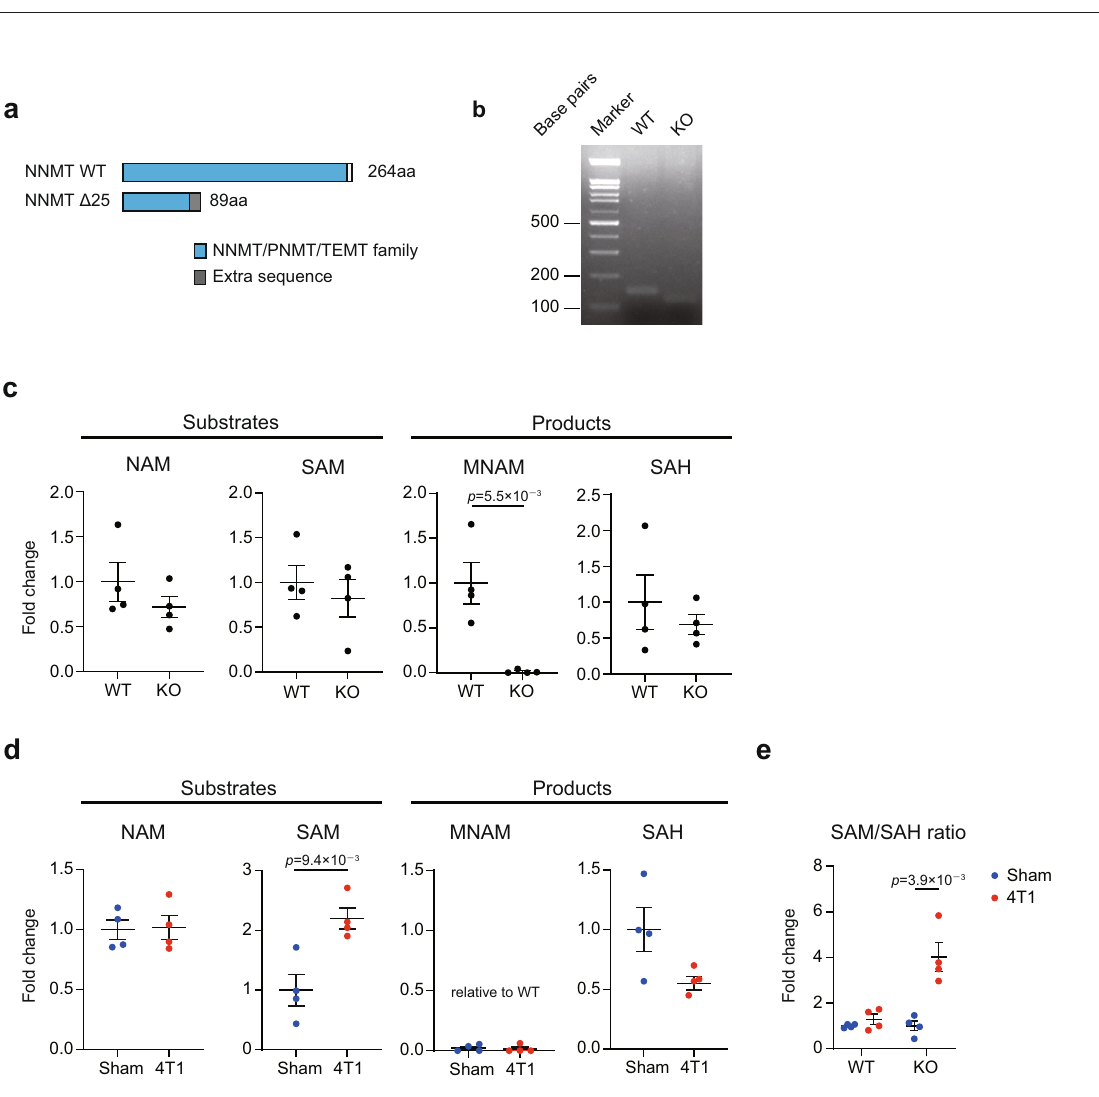
Fig. 1 Solid cancers upregulate Nnmt expression in the liver. a The biochemical property of NNMT. b qPCR analysis for Nnmt in the livers of 4T1-bearing mice on 7 and 14 days after transplantation. n = 6 for D7, n = 4 for D14. c qPCR analysis for Nnmt in the livers of the colon (Colon26), lung (LLC), and ovarian (ID8-F3) cancer-bearing mice. The livers were collected 14 days after transplantation in the colon26 and LLC models, and 42 days after transplantation in the ID8-F3 model. n = 4 for sham-operated mice, LLC-bearing mice, and ID8-bearing mice. n = 5 for Colon26-bearing mice. d Liquid chromatography with tandem mass spectrometry (LC-MS/MS) analysis for nicotinamide (NAM), S -adenosyl-methionine (SAM), 1-methylnicotinamide (MNAM), and S -adenosyl-homocysteine (SAH) in the livers of sham-operated and 4T1-bearing mice. n = 4. e qPCR analysis for Nnmt in a primary hepatocyte culture cell line AML12 treated with the 4T1-conditioned medium determined by qPCR. n = 3. f LC-MS/MS analysis for the NNMT-related metabolites in AML12 treated with the 4T1-conditioned medium. n = 8. g qPCR analysis to reveal the effect of TNF α on Nnmt expression in AML12. n = 4. h LC-MS/MS analysis for the NNMT-related metabolites in AML12 treated with TNF α . n = 3. The exact p values are shown (unpaired two-tailed Student ’ s t -test in b – d and paired two-tailed Student ’ s t -test in e – h ). Averaged fold change data normalized to the control groups are presented as the mean ± SEM.Source data are provided as a source data fi le.